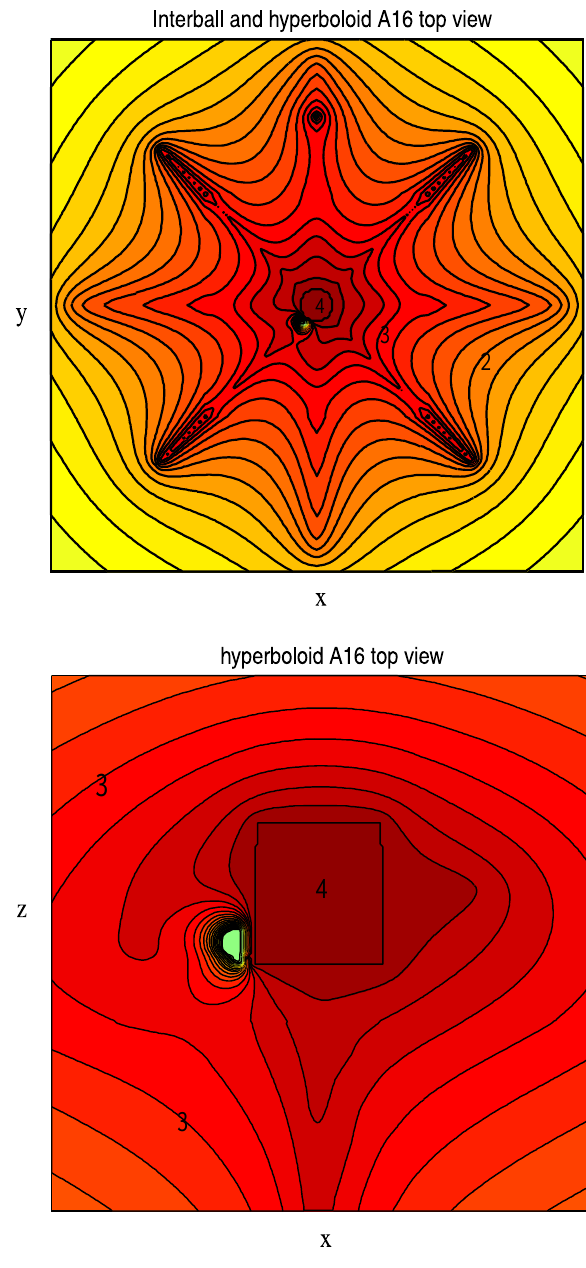
Fig. 2. Equipotential contours in the A16 detector plane for 8 h = − 4V, 8 s = 4V in: (a) the 6 × 6m section in the A16 plane, and (b) the 24 × 24m section in the XY plane at Z = Z C (center of A16). A color scale is displayed, starting from brown for + 4V to green for − 4V (contour step: